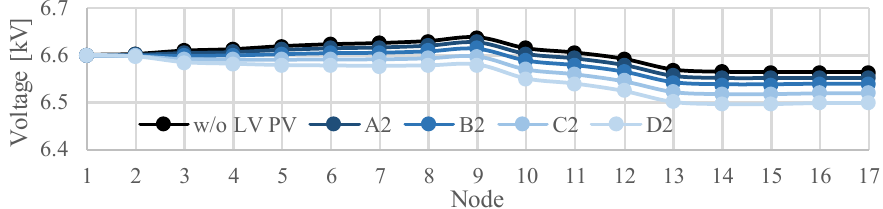
Figure 13. Voltage profile in MV distribution feeder (power factor is set to 0.95).